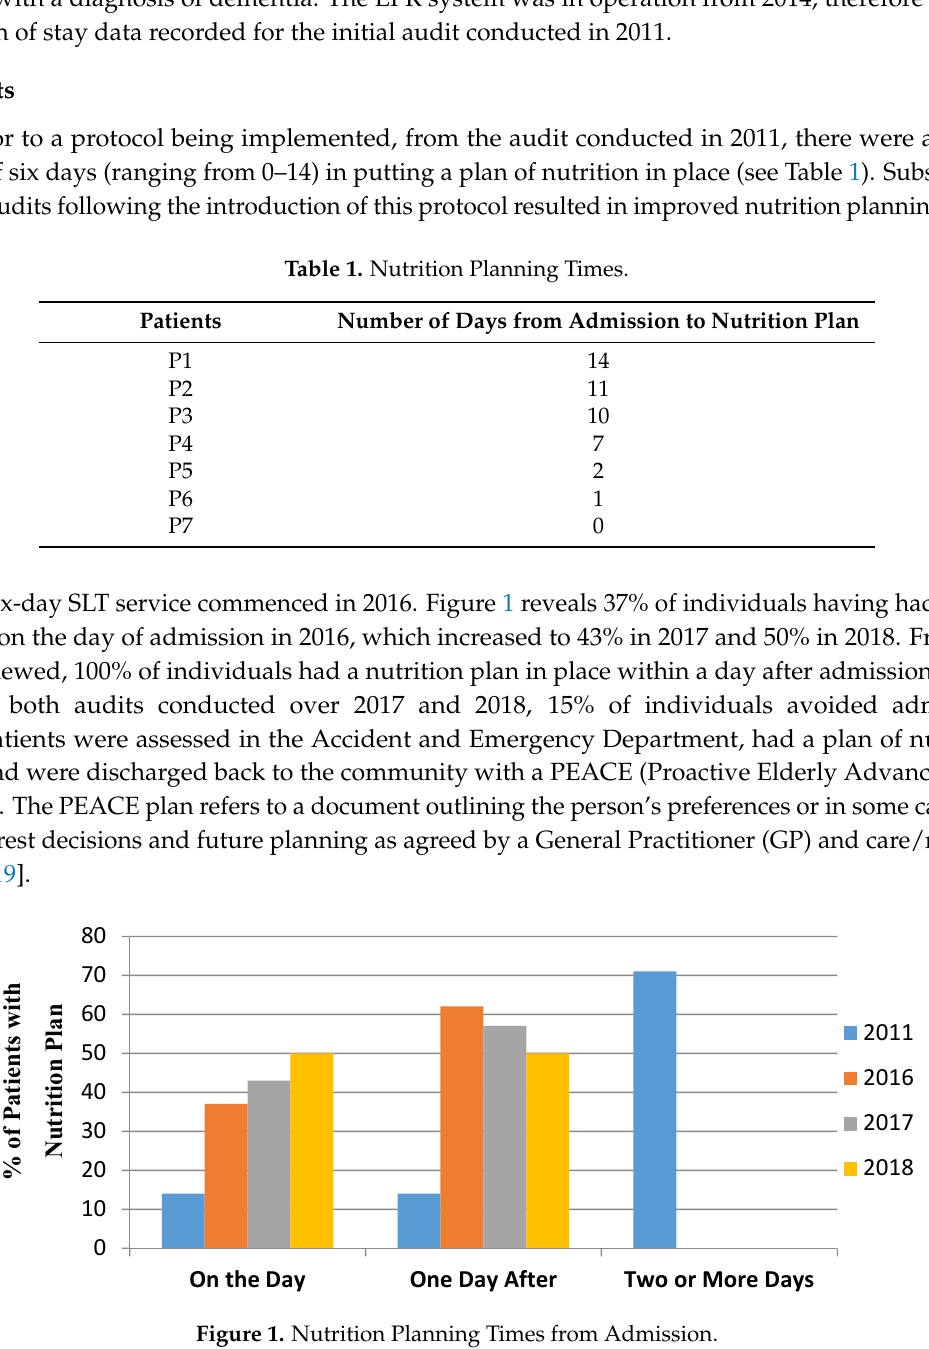
Figure 1. Nutrition Planning Times from Admission.